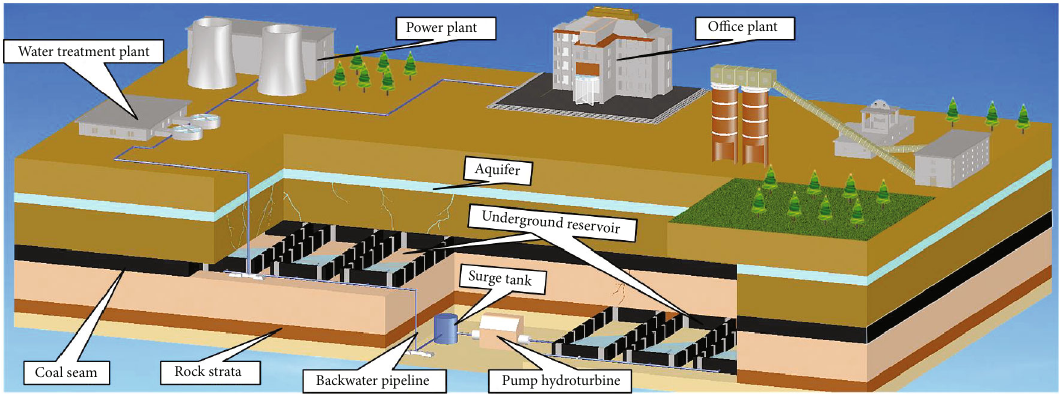
Figure 1: Structure diagram of the underground reservoir in the coal